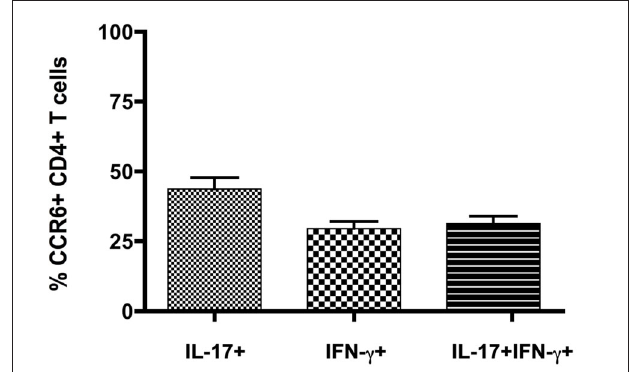
FIGURE 2 | CCR6 expression by IFN γ - and IL17-producing CD4 + T cells in the CNS . Cytokine producing T cells isolated from CNS of mice with severe EAE were detected by flow cytometry following in vitro restimulation and intracellular cytokine staining. CCR6 expression was analyzed on cells gated for CD4 and intracellular IL-17 and IFN γ , relative to isotype control. Bars show means ± SEM ( n =